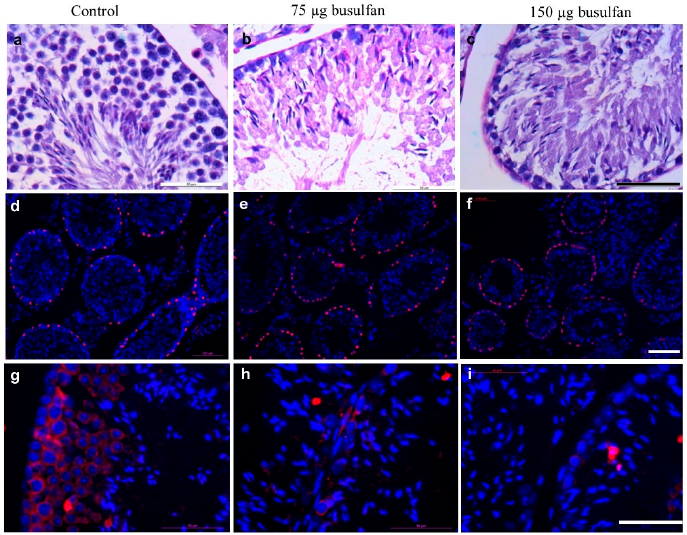
Figure 6. Testis from nude mice sterilized by intratesticular busulfan injection. ( a – c ): Cross sectional histological analysis of mouse testis by periodic acid–Schiff (PAS) staining. ( a ) nontreated control ( b ) two weeks after intratesticular busulfan injection with either 75 µ g or ( c ) 150 µ g. Scale bar: 50 µ m. ( d – f ): Cross sectional immunofluorescent analysis of mouse testis by Sertoli cell marker SRY-Box 9 (SOX9; red) and DNA visualization by DAPI staining (blue) ( d ) non-treated control ( e ) two weeks after intratesticular busulfan injection with either 75 µ g or ( f) 150 µ g. Scale bar: 100 µ m. ( g – i ): Cross sectional immunofluorescent analysis of mouse testis by germ cell marker VASA (red) and DNA visualization by DAPI staining (blue) ( g ) non-treated control ( h ) two weeks after intratesticular busulfan injection with either 75 µ g or ( i ) 150 µ g. Scale bar: 50 µ